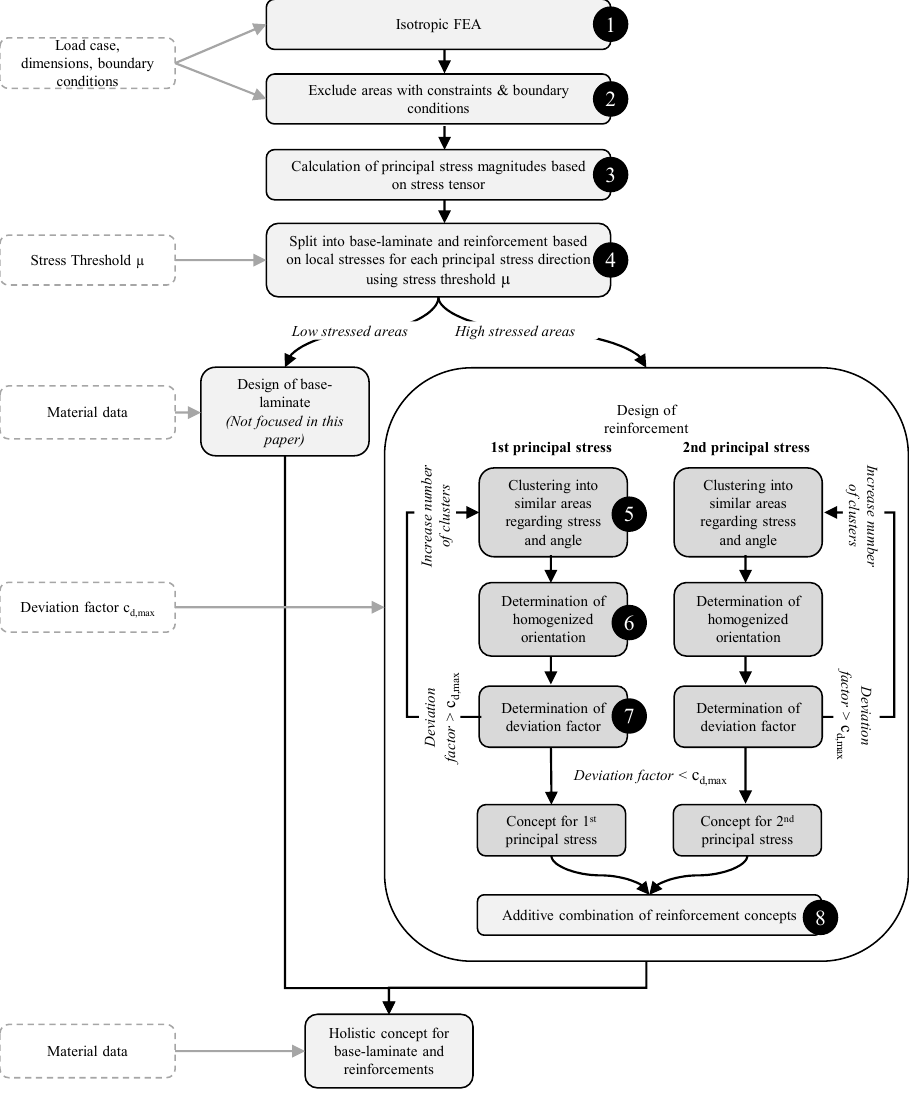
Figure 3. Illustration of the key steps performed in the mechanical model.